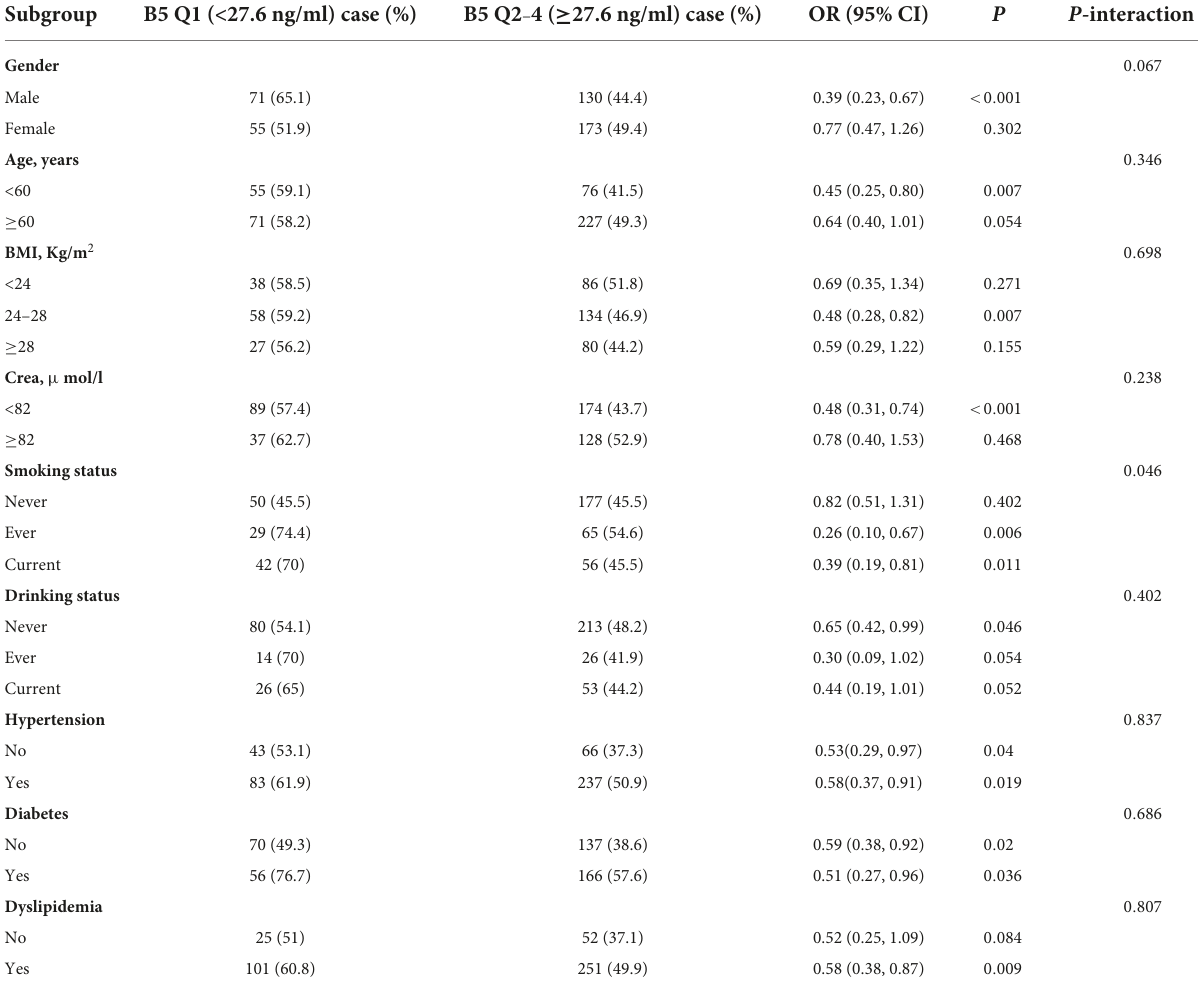
TABLE 4 Subgroup and interaction analyses for the association between vitamin B5 (quartiles 2–4 vs. 1) and coronary heart disease (CHD).